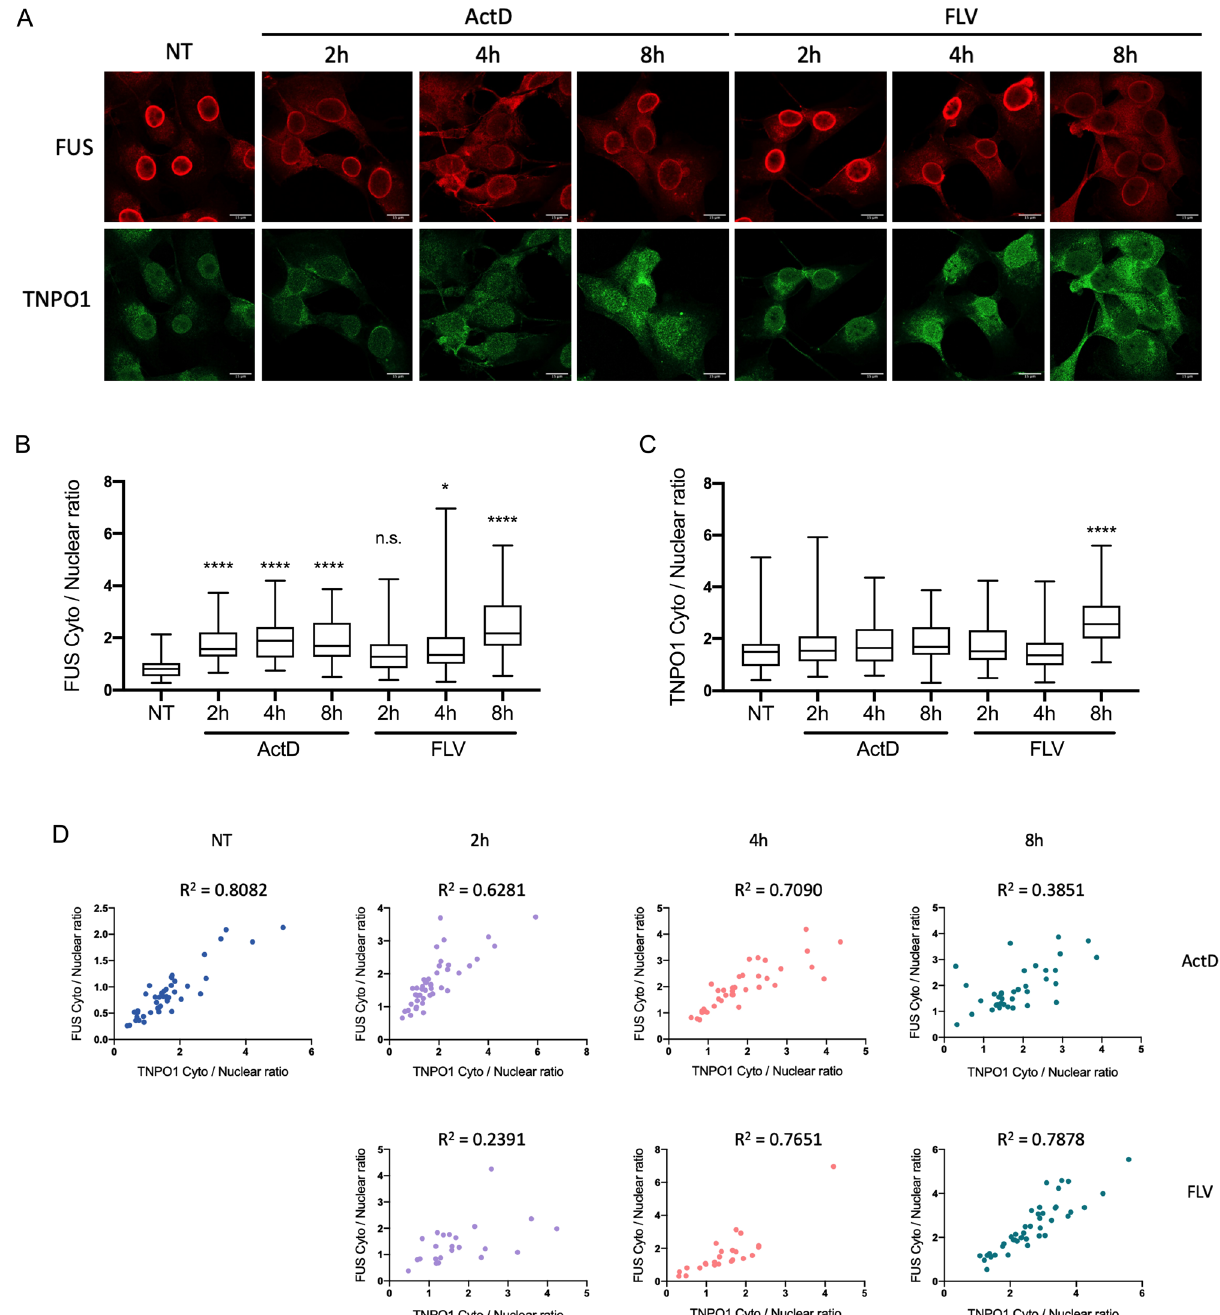
Figure 4. Nucleocytoplasmic localization of TNPO1 is largely unaffected by transcriptional inhibition. ( A ) U87 cells were untreated (NT) or treated with either 5 ug/mL ActD or 1 uM flavo for 2, 4 and 8 h followed by TNPO1 and FUS IF. Scale bars = 15 um. ( B , C ) Cytoplasmic to nuclear FUS ( B ) and TNPO1 (C) ratio quantification in untreated control, ActD- and FLV-treated cells. n = 23–45 cells were analyzed in each experimental condition. (* p = 0.0118, **** p < 0.0001) Dunn’s multiple test. ( D ) Pearson correlation analysis of FUS and TNPO1 cytoplasmic to nuclear expression, when CRM1 is inhibited by LMB 37,38 . We observed increased dose-dependent p53 expression and elevation of the p53 target p21 in LMB-treated U87 cells (Supplemental Fig. S7A). Moreover, we found that LMB did not affect bulk nucleocytoplasmic poly(A+) RNA distribution within the time frame and LMB dosage used (Supplemental Fig. S7B). Therefore, our data shows that FUS cytoplasmic translocation following transcriptional inhibition occurs independently of CRM1-mediated nuclear export.